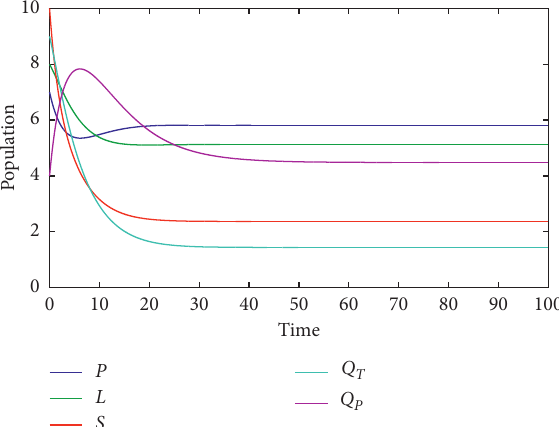
Figure 3: The evolution of the population when R